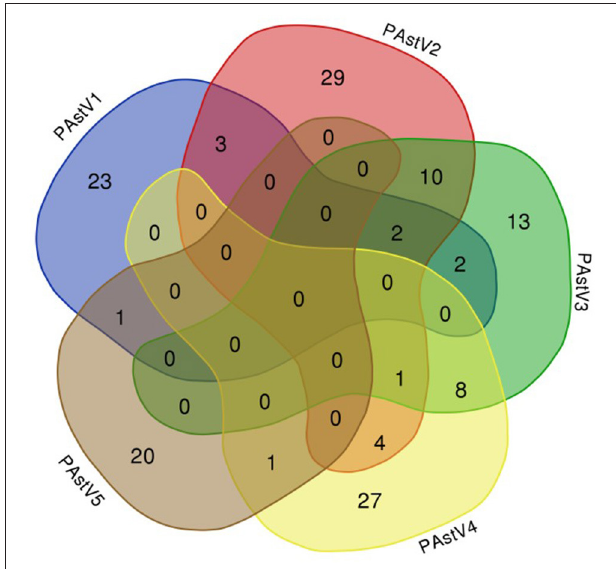
FIGURE 5 | Venn diagram showing the total and proportion of positive samples for each porcine astrovirus (PAstV) genotype. The overlapping areas indicate the total samples that were positive in one to three different genotypes by multiplex RT-PCR.